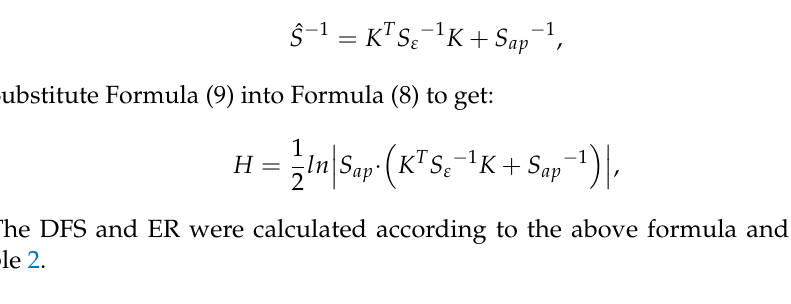
Table 2. Ozone DFS and ER of FY-3D/HIRAS at different experimental